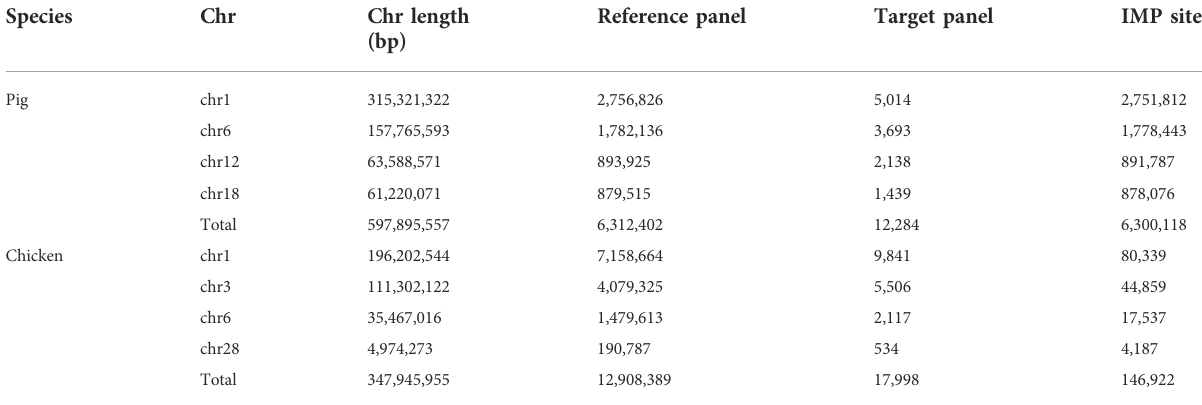
TABLE 3 Scenarios used to evaluate imputation